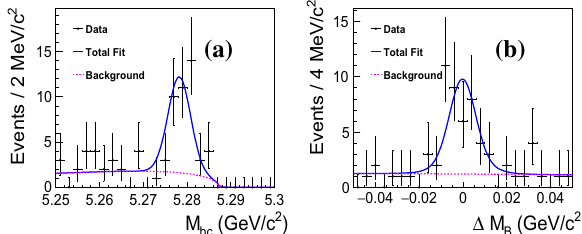
Fig. 2 The (cid:4) c -signal-enhanced distributions of a M bc in the (cid:11) M B signalregionand b (cid:11) M B inthe M bc signalregionfor B 0 → K 0 combining three exclusive final states. The dots with error bars are data, the solid blue curves are the best-fit projections to the distributions, and the dashed magenta lines are the fitted backgrounds